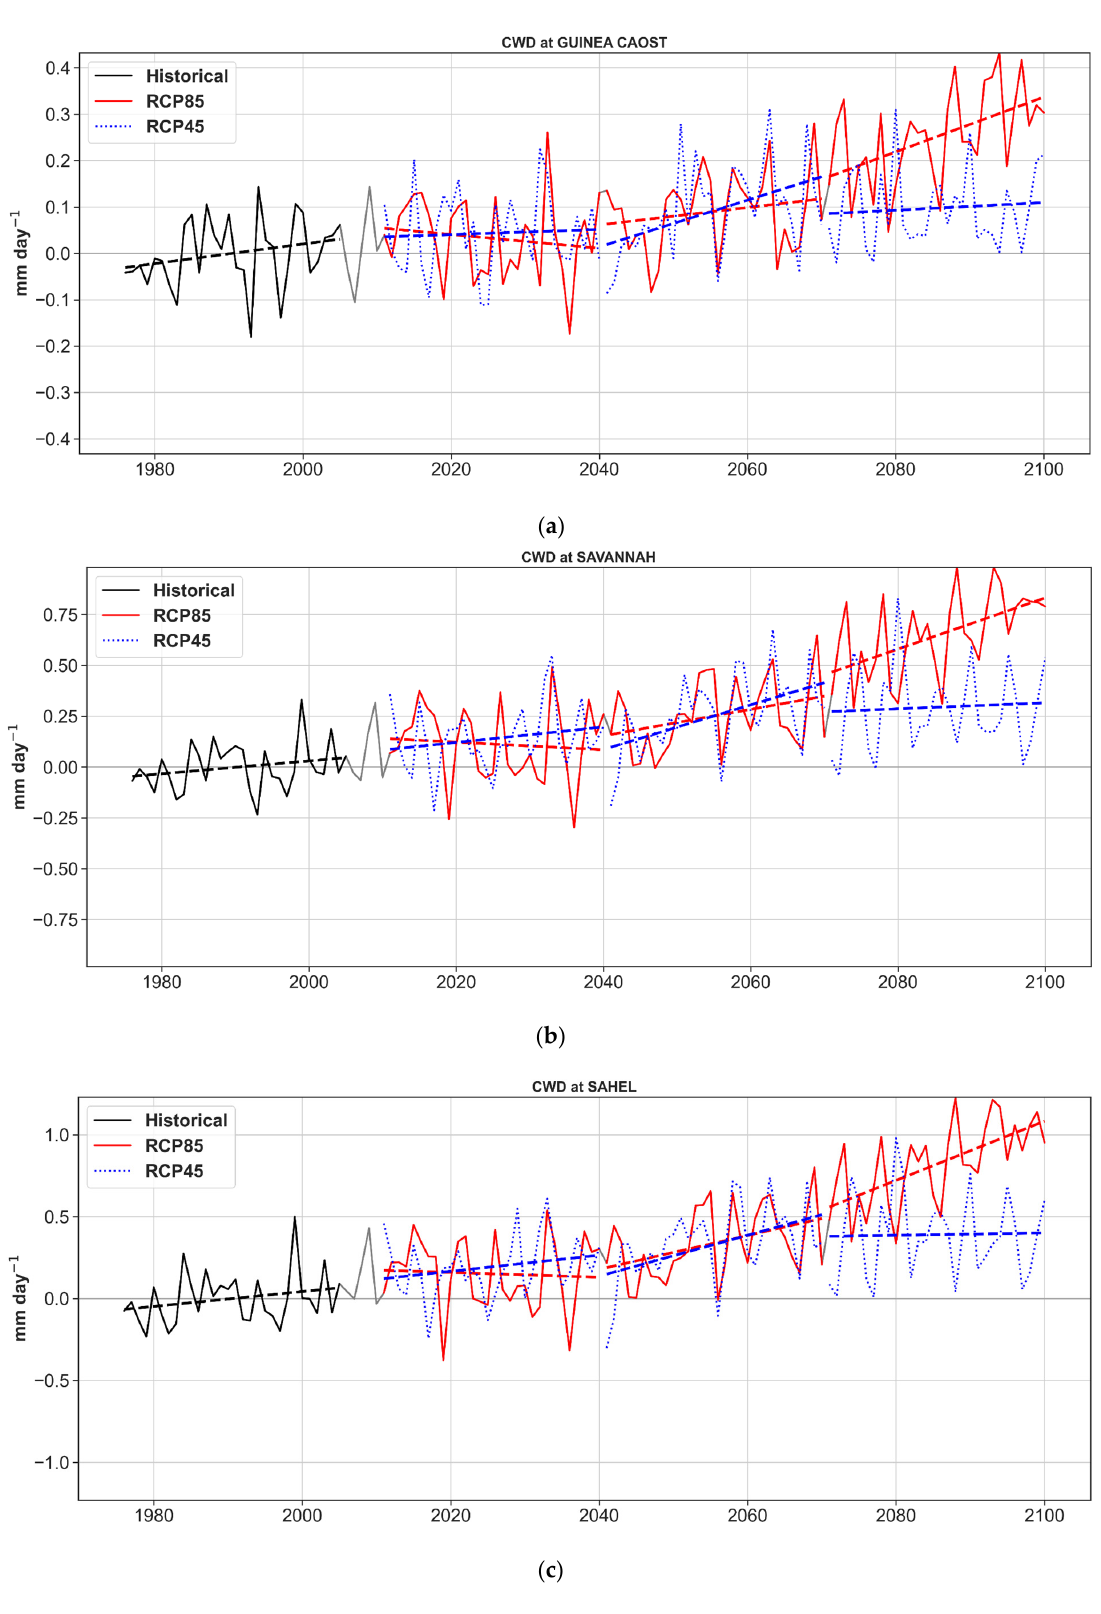
Figure 8. Historical and projected time series of annual mean daily CWD (mm/day) at ( a ) Guinea Coast, ( b ) Savannah, and ( c ) Sahel. The black line represents the historical period, while blue and red lines represent predicted values under RCP 4.5 and RCP 8.5 emission scenarios, respectively. The plotted values are departure from the baseline (1976–2005).